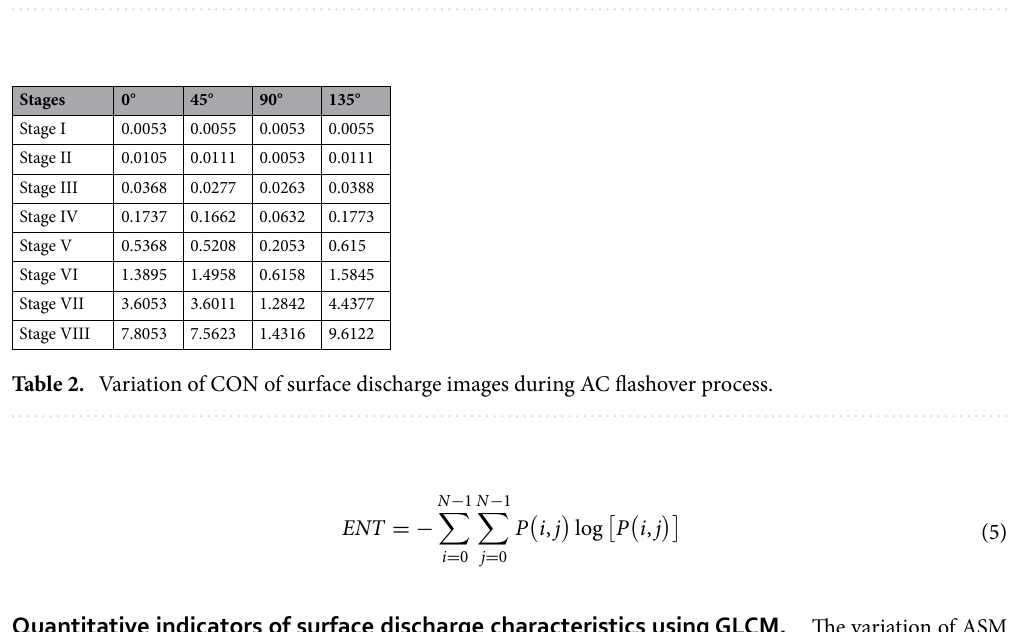
Table 1. Variation of ASM of surface discharge images during AC flashover process.